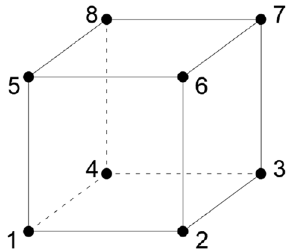
Figure 1. Eight-node brick element.